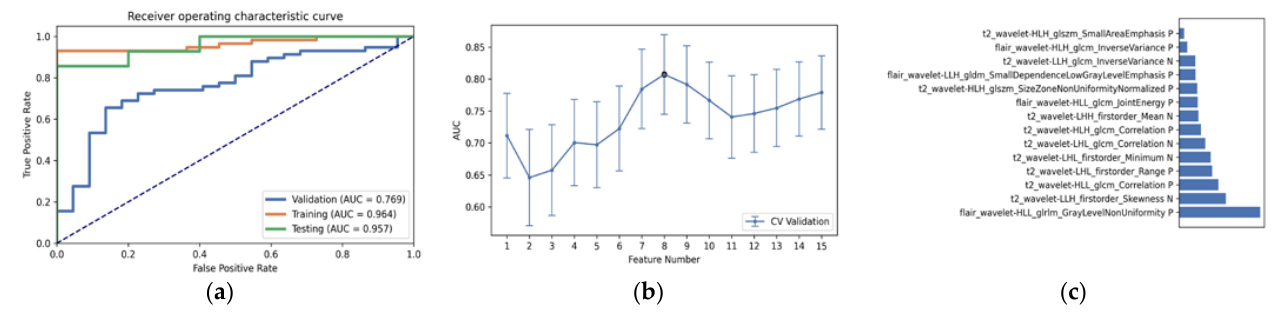
Figure 3. The best performance generated by the “6-Step” general radiomics model was the T2+FLAIR combined multi-sequence with the following settings: wavelet image filter, mean data normalization, PCC dimension reduction, RFE feature selection, and SVM classifier. ( a ) Receiver operating characteristic (ROC) curves of the training, testing, and validation sets; ( b ) the FAE software’s suggestion of a candidate 14-feature model according to the “one-standard error” rule; ( c ) the 14 radiomic features with the highest average feature importance calculated by the best settings with the T2+FLAIR combined multi-sequence.